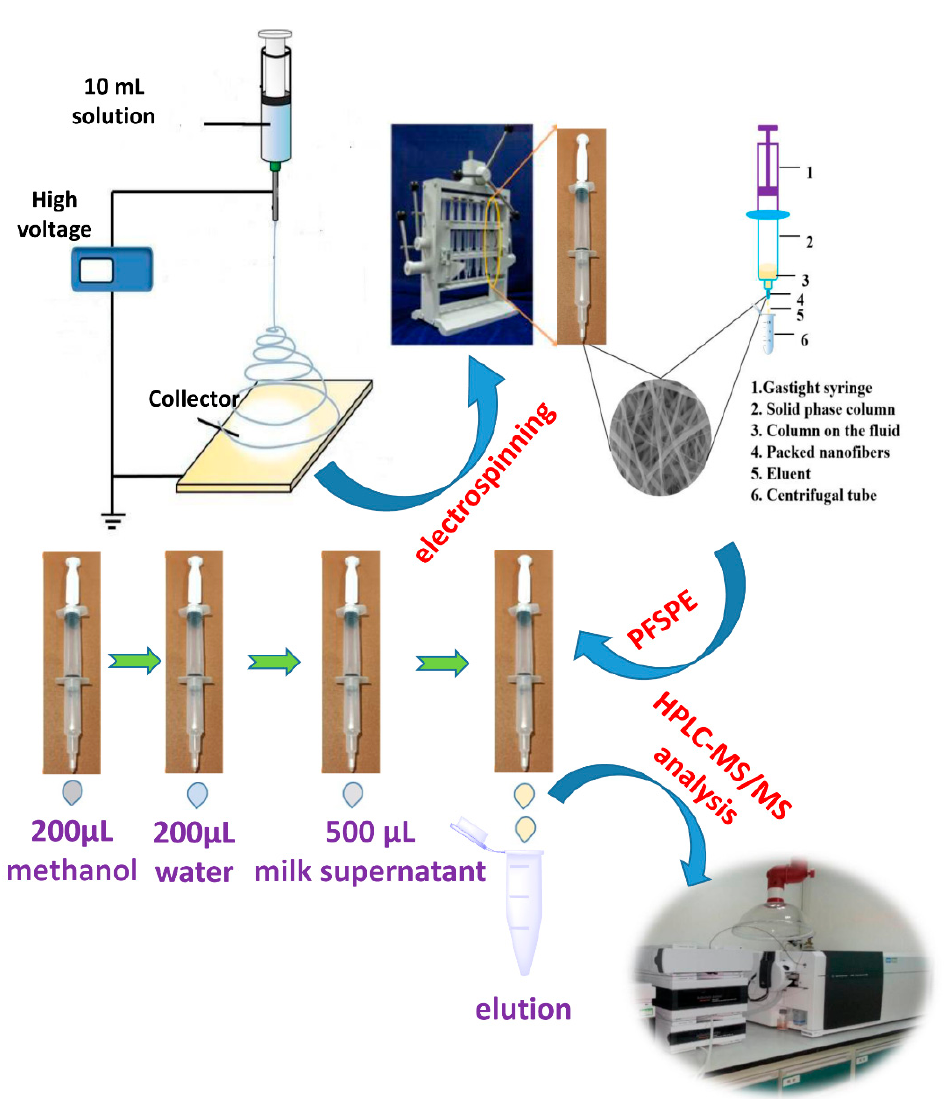
Figure 1. Schematic of packed-nanofiber solid-phase extraction process.